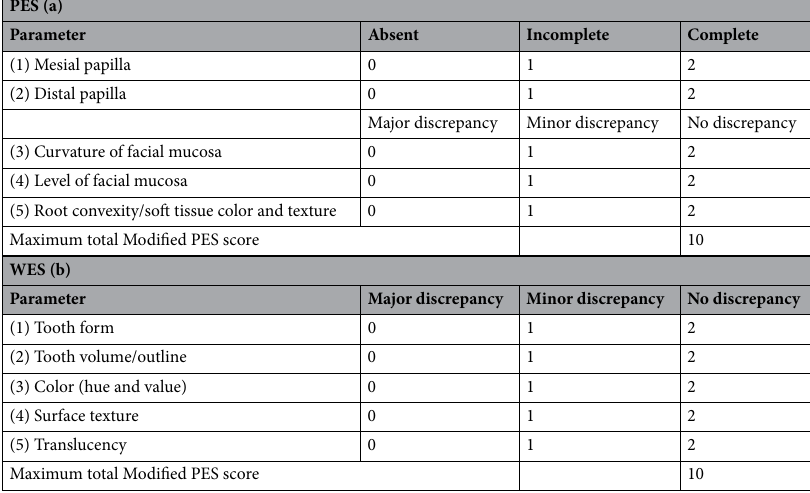
Table 1. Detailed description of the parameters evaluated by the PES (a) and WES (b).